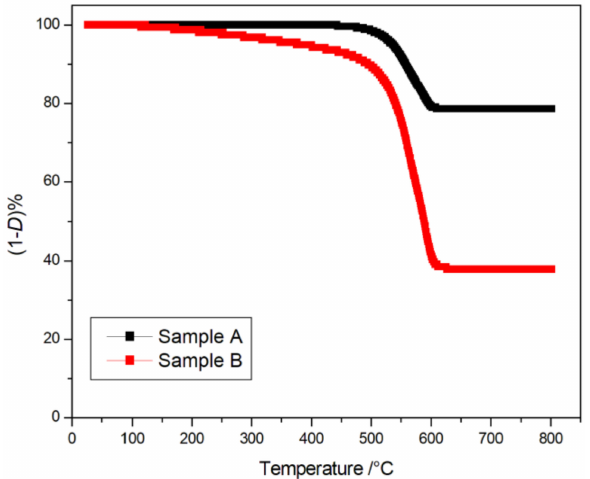
Figure 3. TG degradation curves in air for sample A and sample B (ramp rate: 10 ◦ C · min − 1